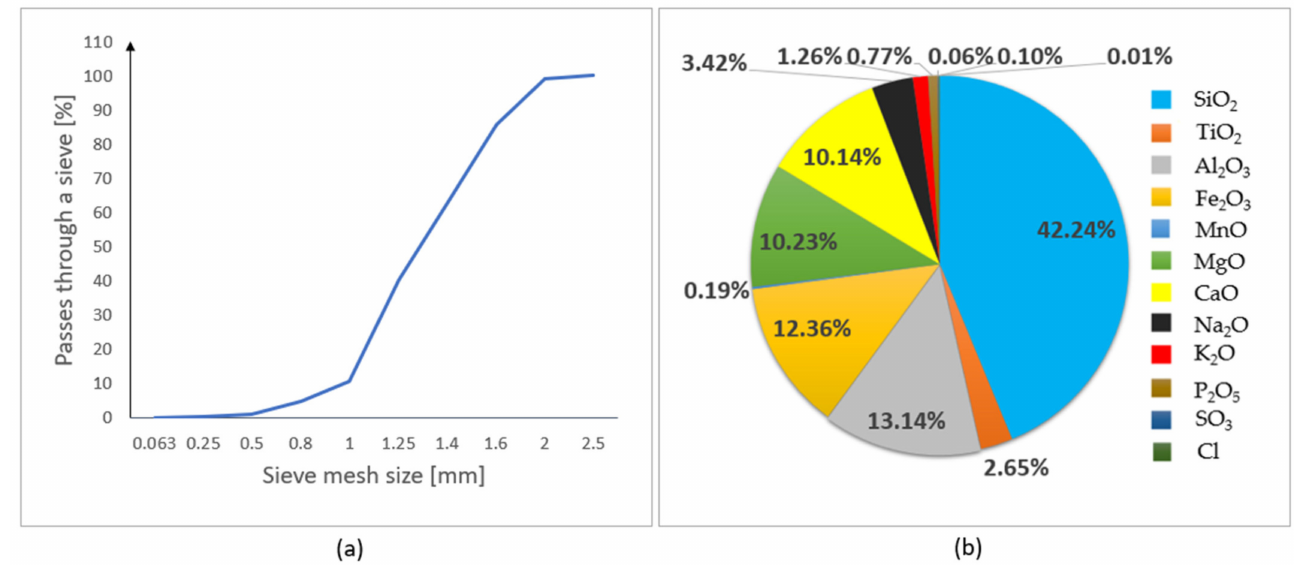
Figure 2. Properties of the basalt fine aggregate: ( a ) particle size distribution; ( b ) chemical composi- tion.